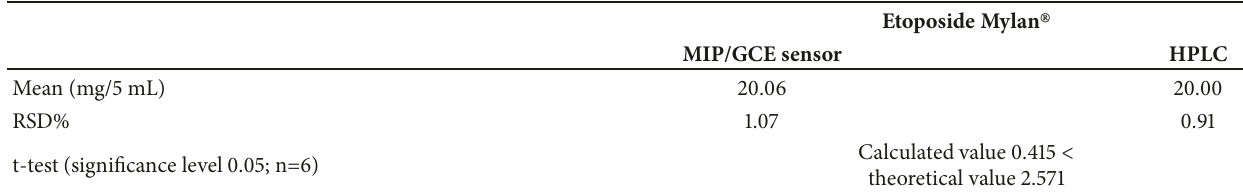
Table 3: Determination of ETP in injectable solution (n=6) using the proposed MIP/GCE sensor and reported HPLC method [11]. Mean (mg/5 mL) RSD% 1.07 0.91